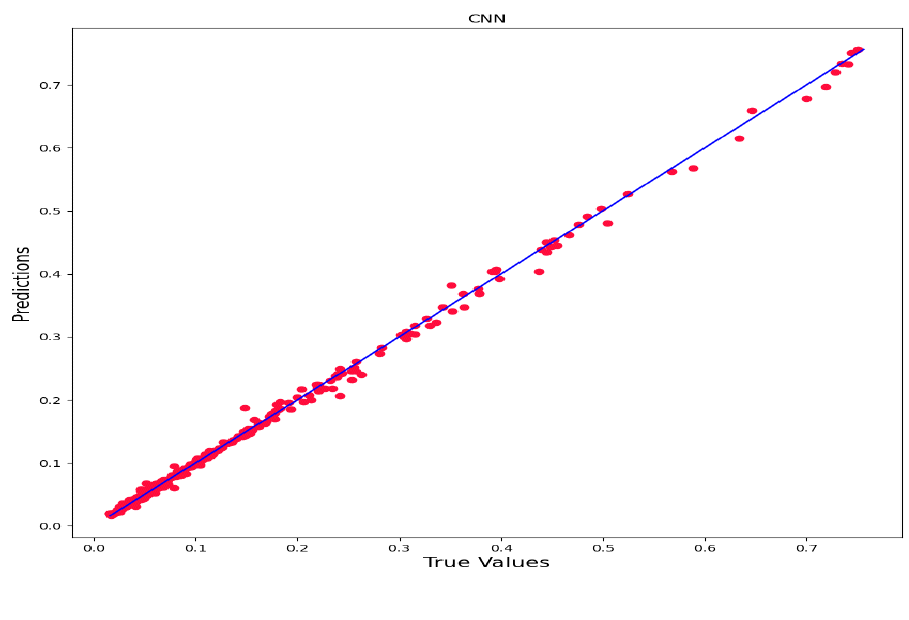
Figure 6. Forecasting results of CNN. According to the empirical evidence, the best performance on the test set was ob- tained from CNN with MAPE of 0.0404 when the number of nodes are set as 100. The second-best performance is obtained from the GRU with MAPE of 0.0613 when number of nodes are set at 40 while the third-best performance comes from LSTM with 0.0746 when number of nodes are set to 20.